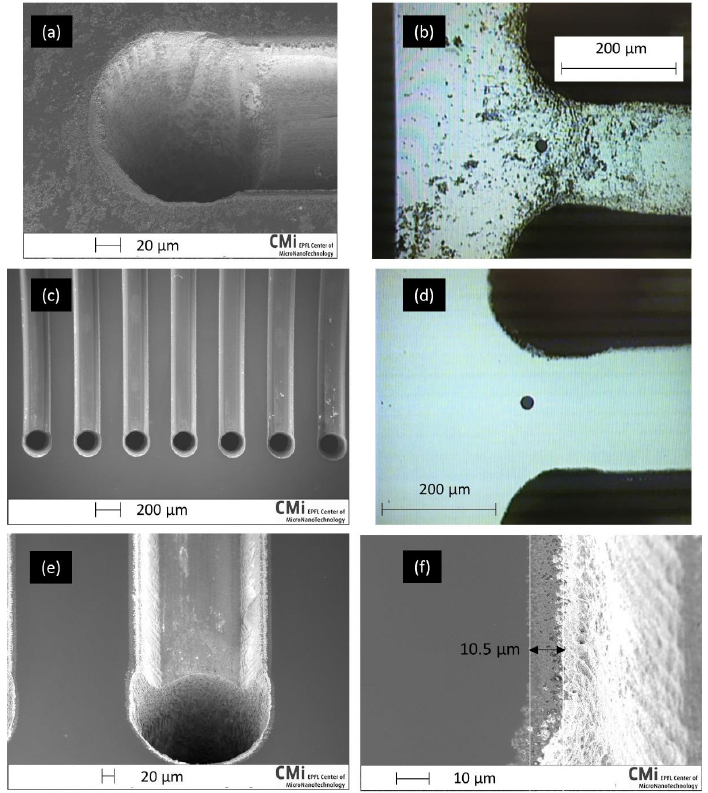
Figure 10. SEM and optical images of the wafer surface after oxide removal ( a , b ) and after the polishing ( c – f ). The back dot on ( b , d ) is an artefact from the observation device. The bonding of the wafer stack exhibited good quality with minor defects confined at the edges, with the exception of one stack where defects were also seen in a localized inner region of the wafer, fortunately far from any etched area, as shown in Figure 11 (left). The wafers were subsequently diced, as shown in Figure 11 (right). Figure 11. Wafer stack after bonding (left) and dicing (right). Some bonding defects are visible at the wafer edge and one in the inner region, all far from the channels.